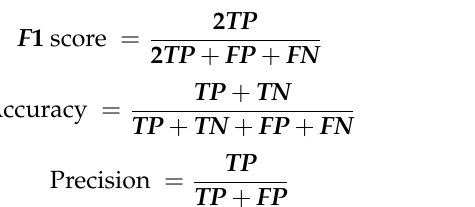
Table 5. System performance evaluation with datasets.